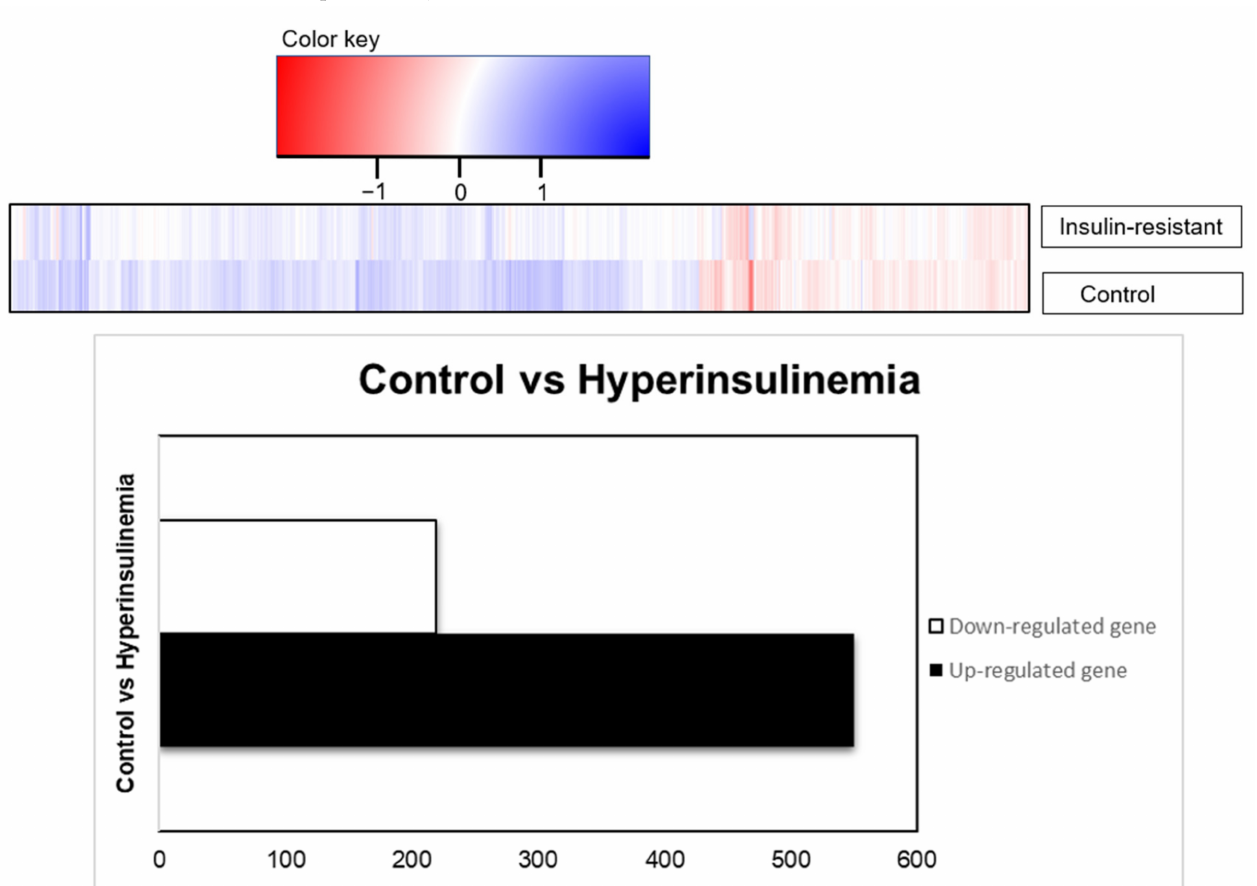
Figure 5. RNA transcriptomic profiling, based on differential expression genes presented as total genes, were downregulated (219 genes) or upregulated (550 genes) based on the adjusted p -values ( p <